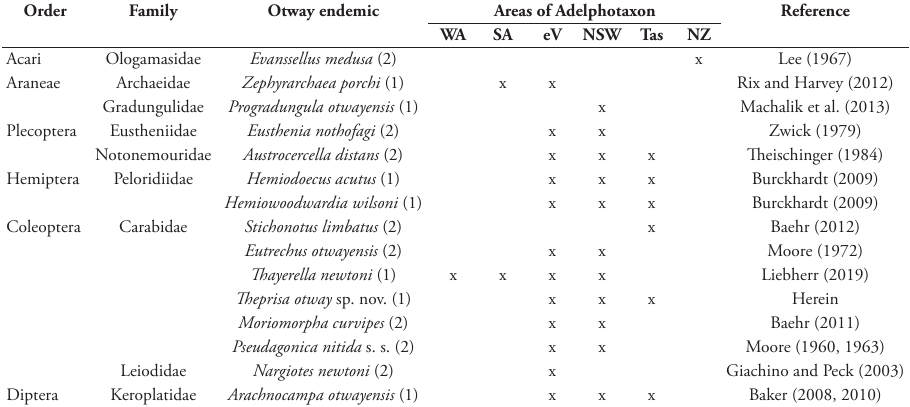
Table 1. Examples of species precinctive to the Otway Ranges, along with the aggregate distributions of closely related species. Adelphotaxa to Otway endemics may be circumscribed by a phylogenetic hypoth- esis (1), or defined by common membership in a generic-level or species-group taxon (2). Abbreviations of geographic areas include: WA, Western Australia; SA, South Australia; eV, eastern Victoria; NSW, New South Wales; Tas, Tasmania; NZ, New